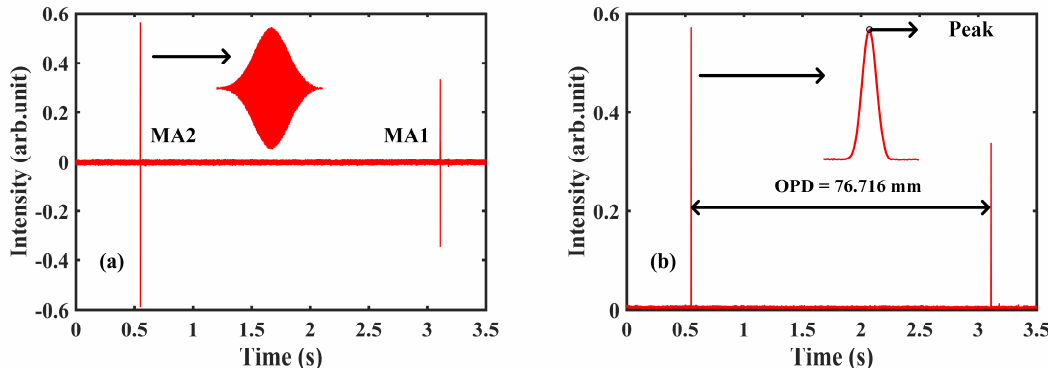
Figure 4. ( a ) Cross-correlation patterns without water in the tank; ( b ) results of the Hilbert